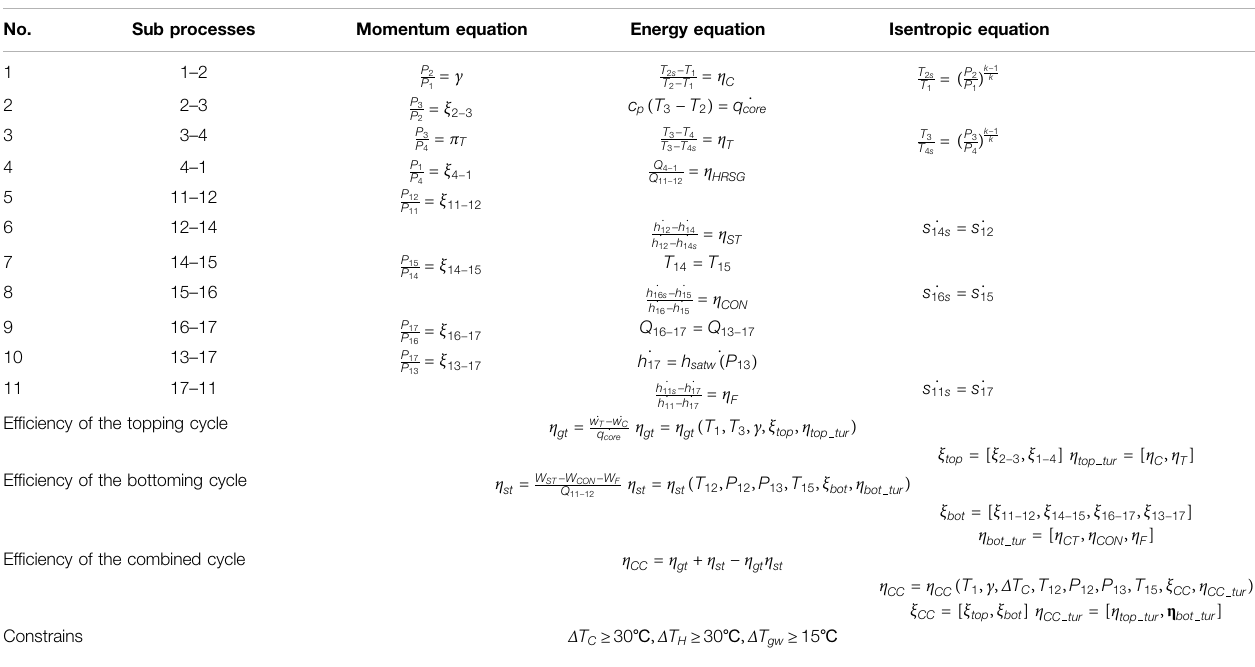
TABLE 2 | Thermodynamic model of the combined